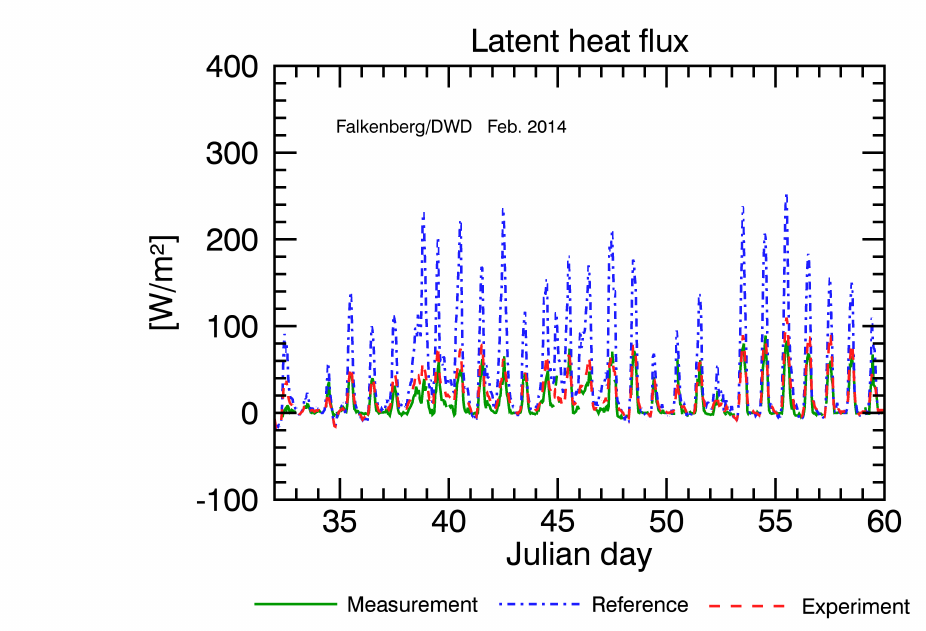
Figure 3. Diurnal cycles of the total latent heat flux as measured at Falkenberg in February 2014 compared to the results of the reference version of TERRA based on BATS and of the new scheme based on a resistance formulation